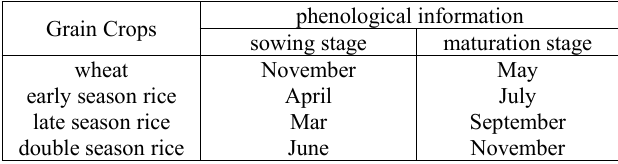
Table 4. The phenological information of different grain crops